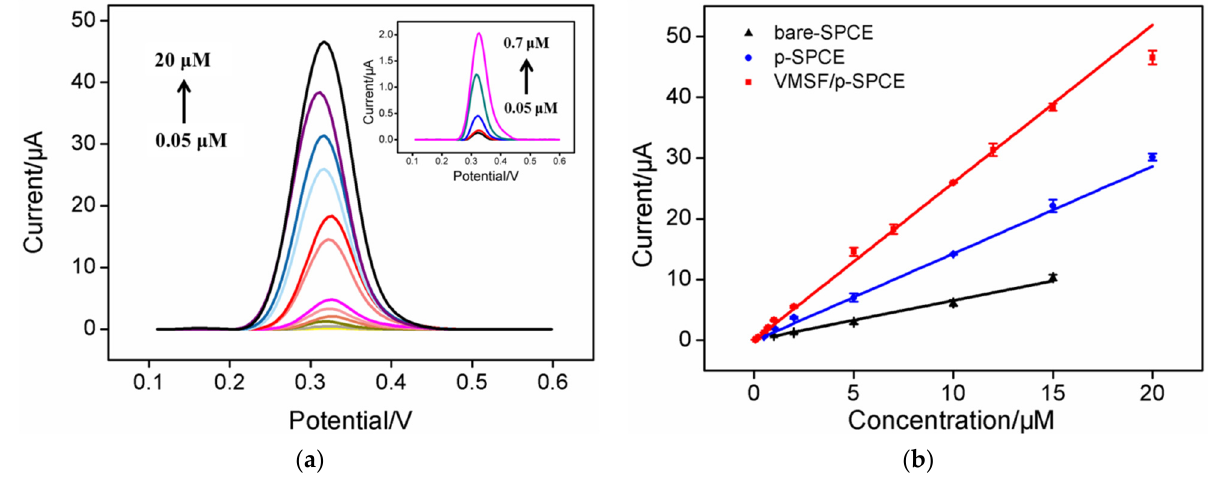
Figure 5. ( a ) Differential pulse voltametric curves of VMSF/p-SPCE toward various concentrations (0.05, 0.1, 0.2, 0.5, 0.7, 1, 2, 5, 7, 10, 12, 15, 20 μ M) of CLZ. The inset is an enlarged image of the curves at low concentrations. ( b ) Corresponding calibration curves for the determination of CLZ using VMSF/p-SPCE, p-SPCE, or bare SPCE.